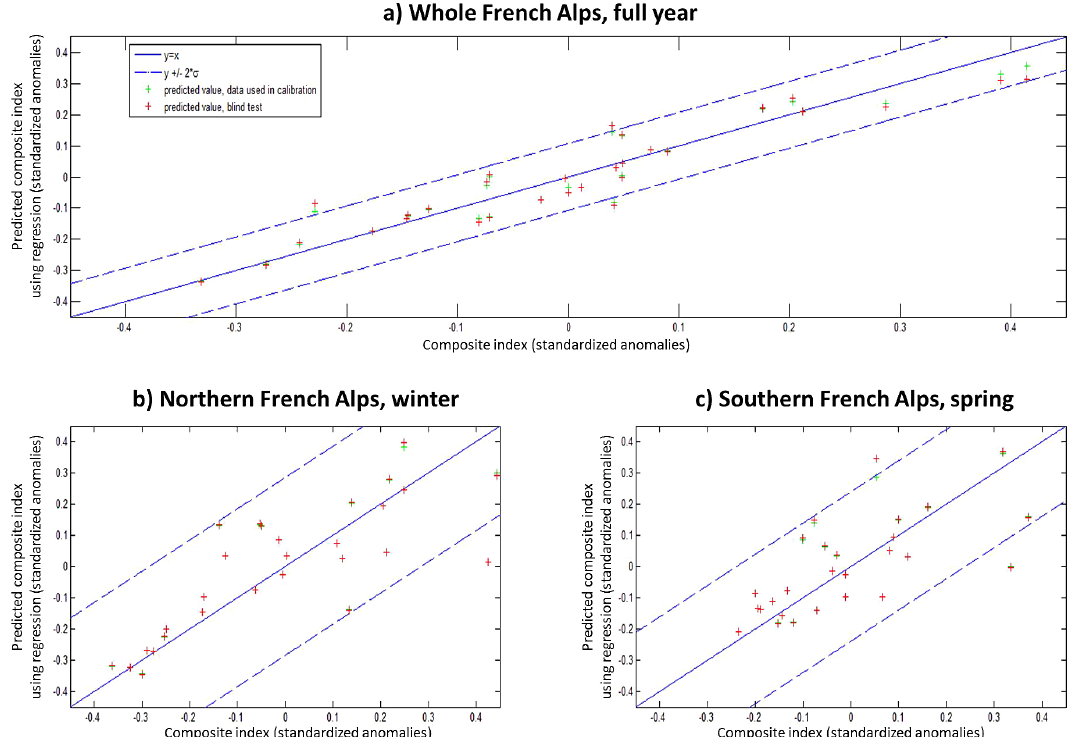
Figure 2. Cross-validation of the composite index regression model for the reference period: entire French Alps for the full avalanche year (a) , northern French Alps in the winter season (b) and southern French Alps in the spring season (c) . In each panel, the predictive performance is assessed with/without (leave-one-out scheme) each pseudo-observation. To represent predictive uncertainty around the first bisector, the classical bandwidth of ± two standard deviations is